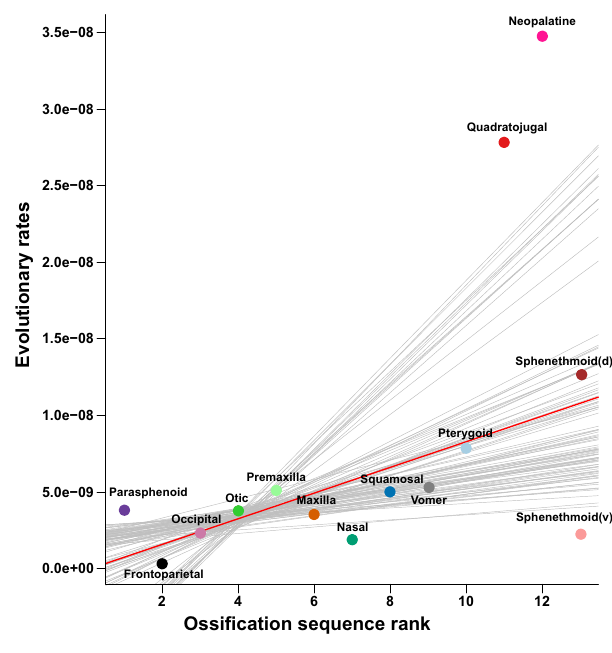
Fig. 6 Ossi fi cation sequence and evolutionary rate. Ossi fi cation sequence rank versus evolutionary rate for each cranial region. Evolutionary rates are estimated with error to account for intraspeci fi c variance and departures from Brownian Motion (results estimated without error in Supplementary Fig. 11), with lines derived from a robust regression fi t. Two-sided Spearman ’ s rank correlation of evolutionary rate with ossi fi cation sequence rank (from Weisbecker & Mitgutsch 43 ) was signi fi cant (mean Spearman ’ s rho = 0.50, p < 0.01). Colours for cranial regions are as indicated in Fig.